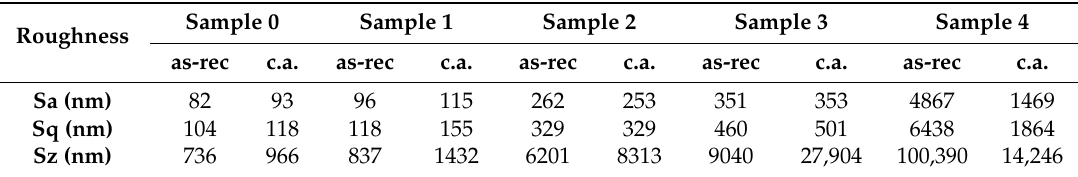
Table 5. Roughness parameters average values of all as-received (as-rec) and chemically attacked (c.a.) copper samples.